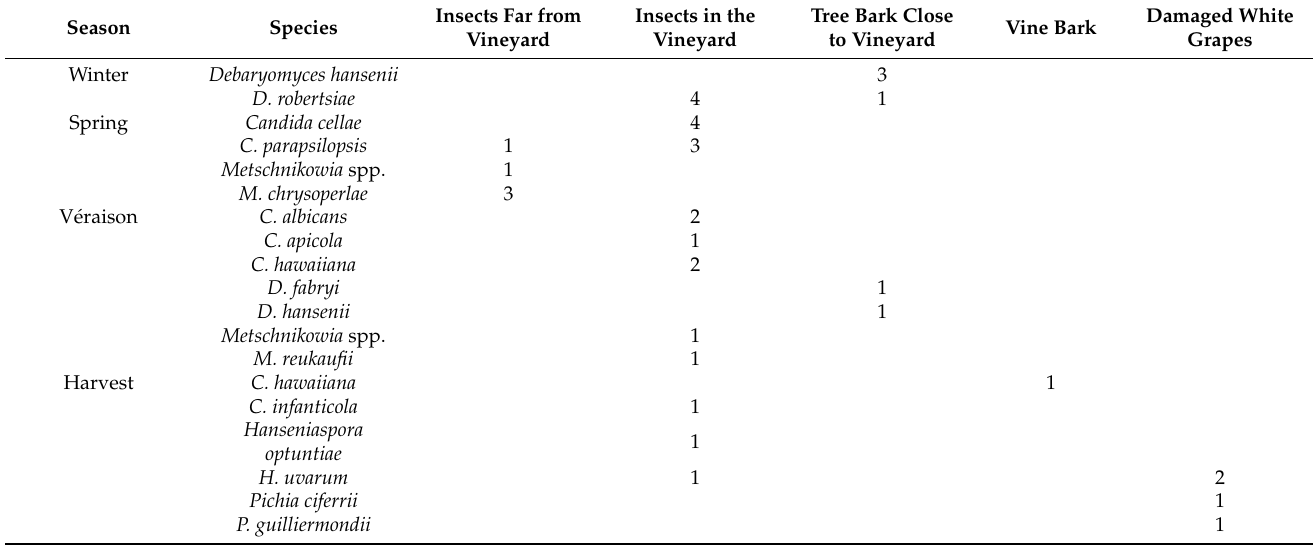
Table 2. Number of samples with ascomycetous species recovered from vineyard environment samples throughout the